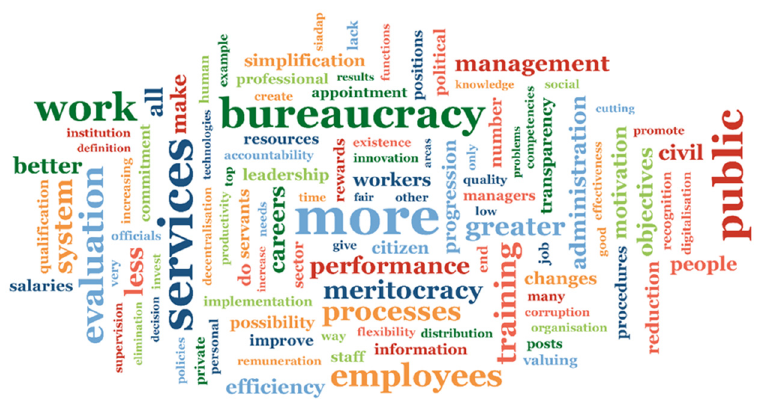
Figure 4. Word cloud on the question “What would you change in PA if you could”? Source: Own elaboration (MAXQDA Analytics Pro20).